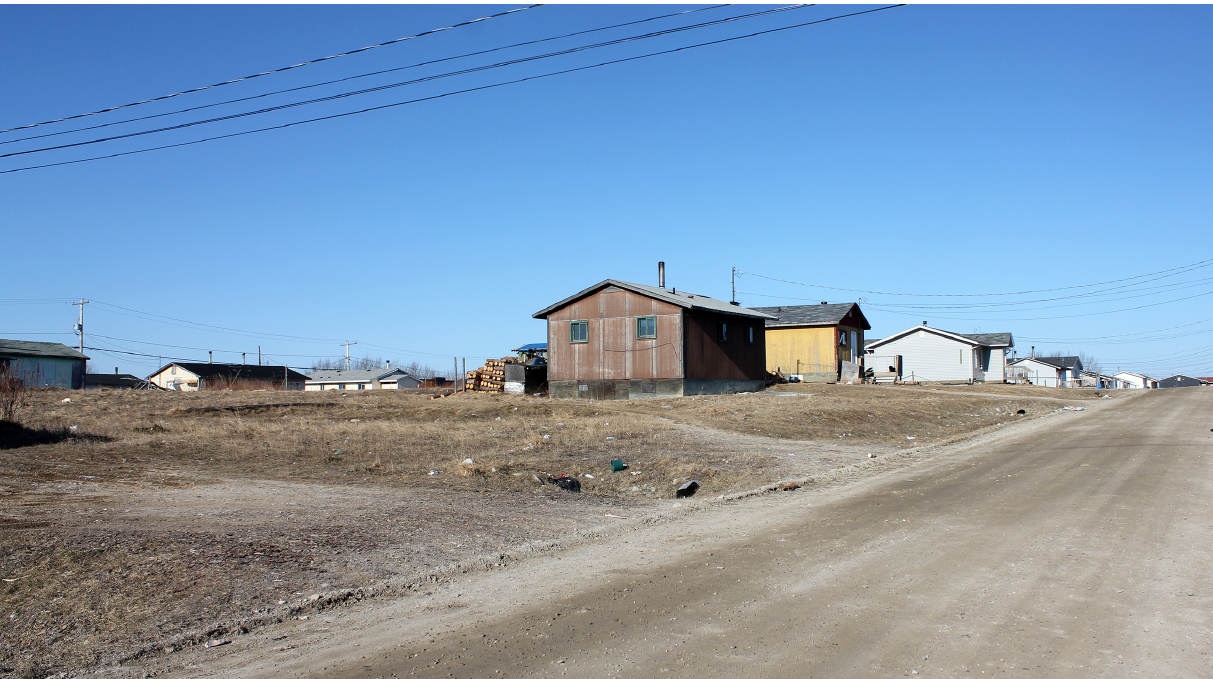
Figure 2. Eabametoong First Nation. Typical ‘suburban’ streetscape of a mid-Canada corridor First Nations community. Source: